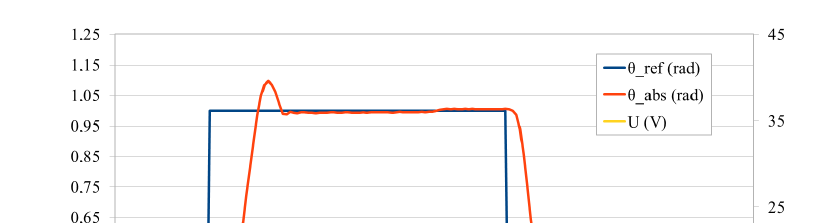
Figure 10. Position controller block diagram.